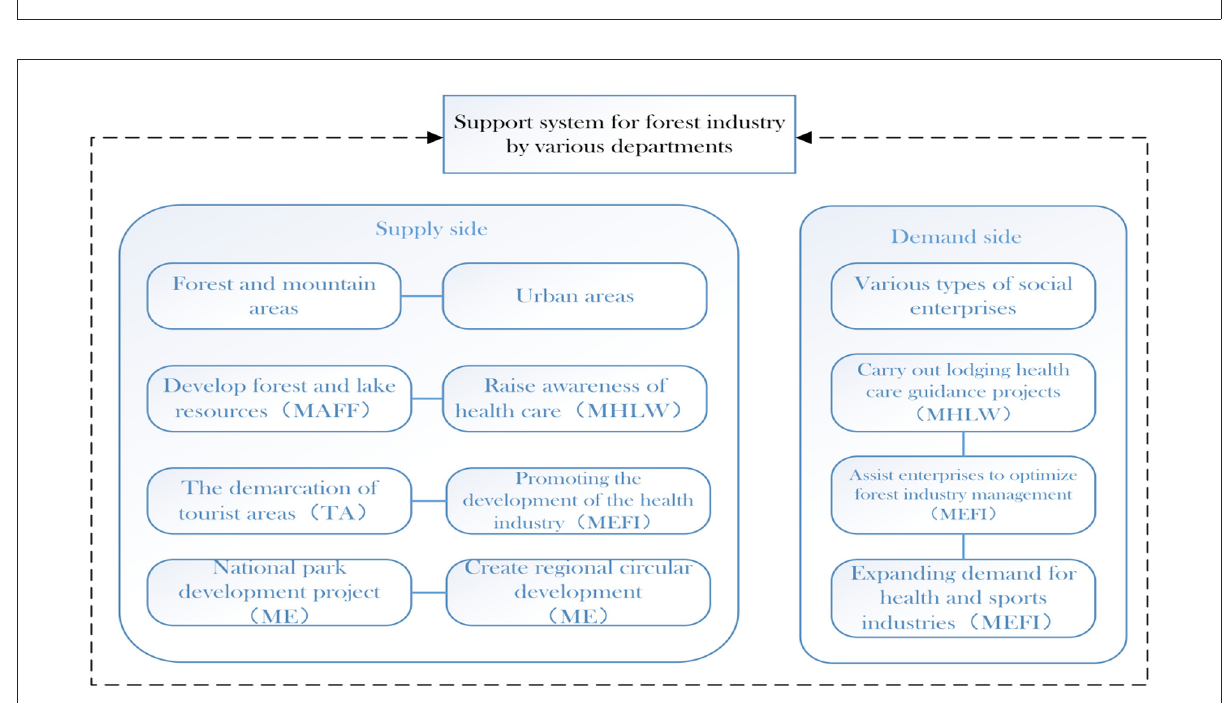
FIGURE8 Japanese government’s policy process on forest service resource